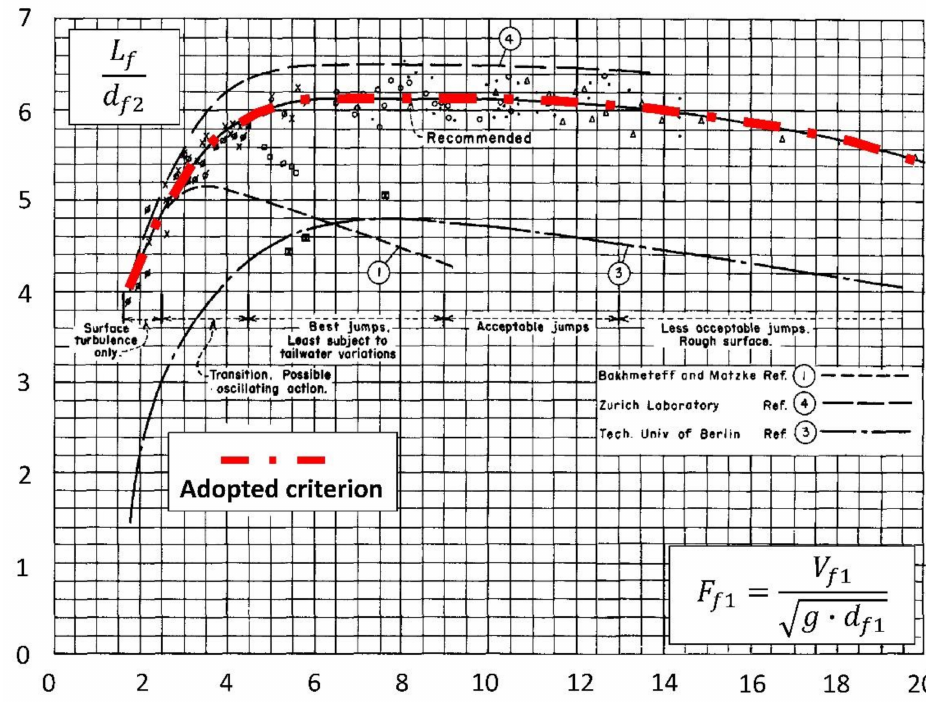
Figure 5. Length of the Type I basin recommended by the BOR (Adapted from Ref. [19]).